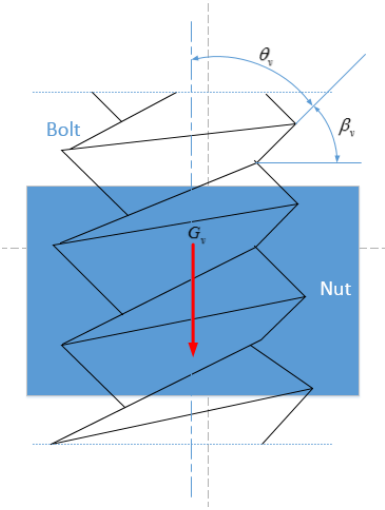
Figure 2. Schematic diagram of threaded connection.